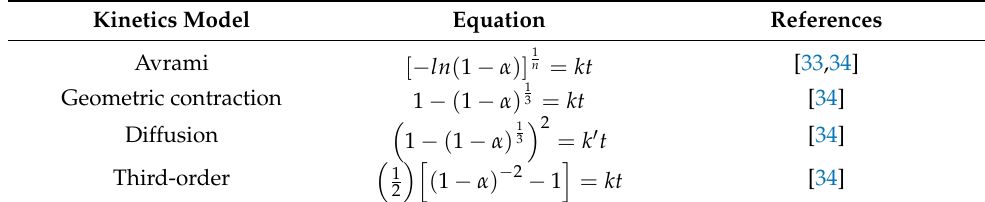
Table 2. Geopolymerization reaction kinetics